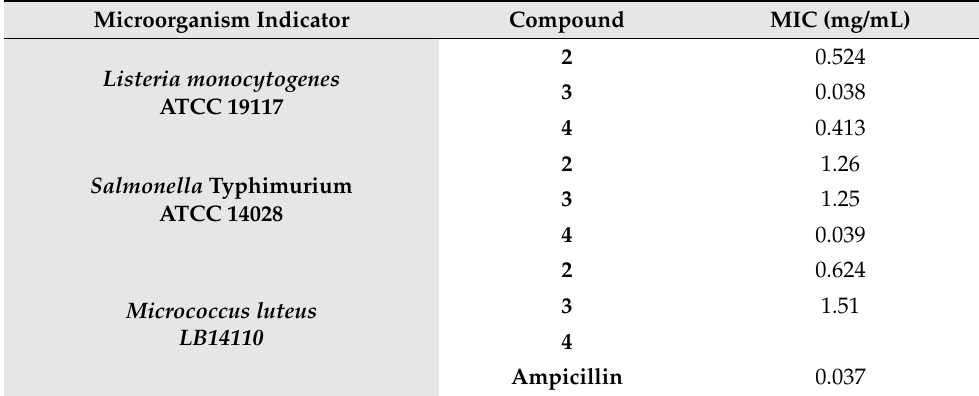
Table 9. Minimal bacterial inhibitory concentration measured in mg/mL of compounds 2 – 4 .